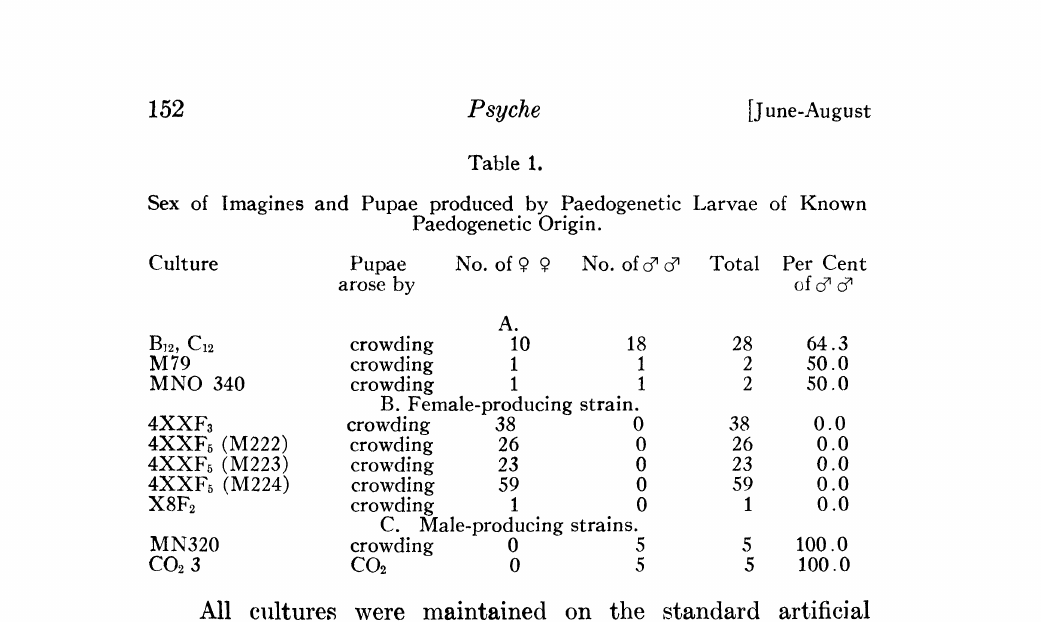
Psyche [J une-Augu st